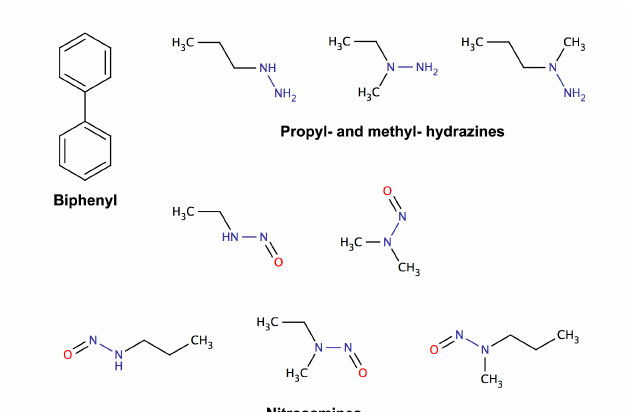
Figure 7: Chemical formula for nine entries detected on the CPDBAS data set through Graph